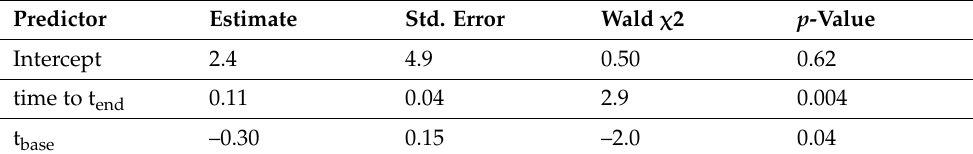
Table 2. The predictors included in the final logistic prediction model. Estimate is the coefficient of the predictor variables with their respective standard errors. p -Value describes the respective significance levels of the variables in the model.